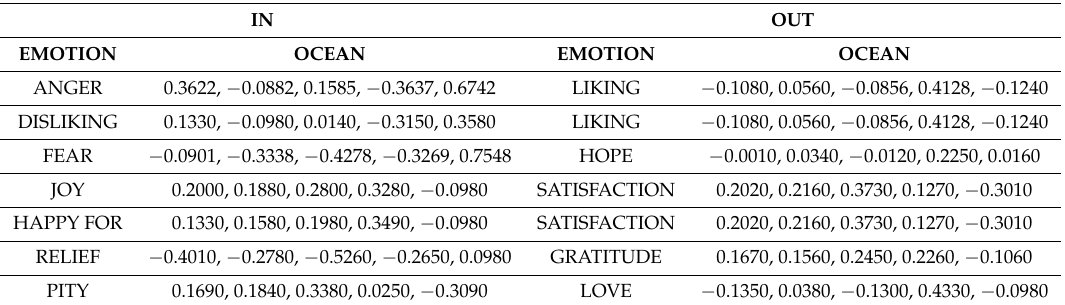
Table 4. Equivalence emotion/incoming personality profile and emotion/outgoing personality